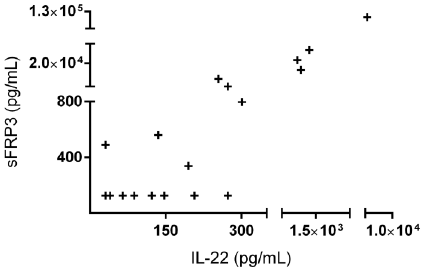
Figure 1. Correlation between interleukin (IL)-22 and secreted Frizzled-related protein (sFRP)3 synovial concentrations. IL-22 and SFRP3/FRZB concentrations measured in synovial fl uid of 19 patients with different in fl ammatory joint diseases (two of these presented the exact same pair value so only 18 dots are shown). The nine lower values of sFRP3 and the three lower values of IL- 22 represent imputed data of observations below the method ’ s detection limit (informed by the manufacturer as being 31.1 pg/mL for IL-22 and 125 pg/mL for sFRP3). Spearman r coef fi cient=0.76. P=0.002.